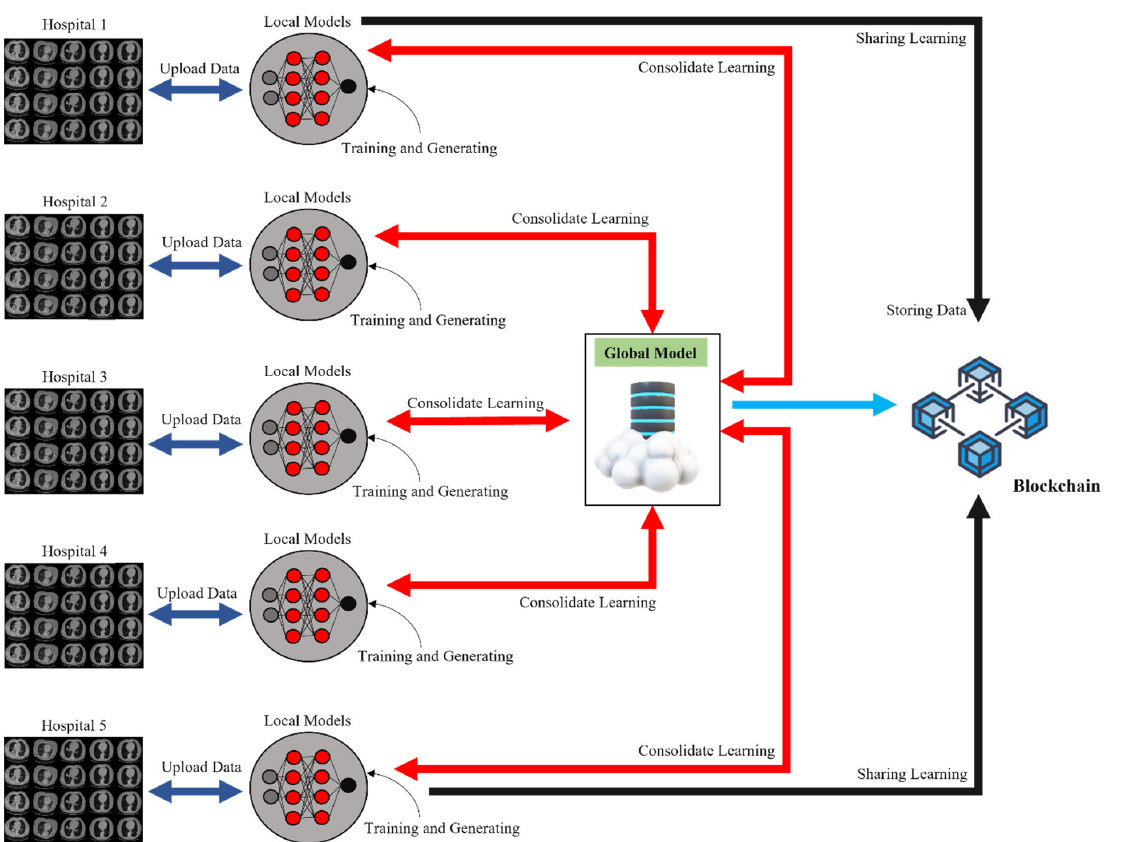
Figure 2. Proposed blockchain-based FL framework used for the identification of COVID-19 through CT scans.